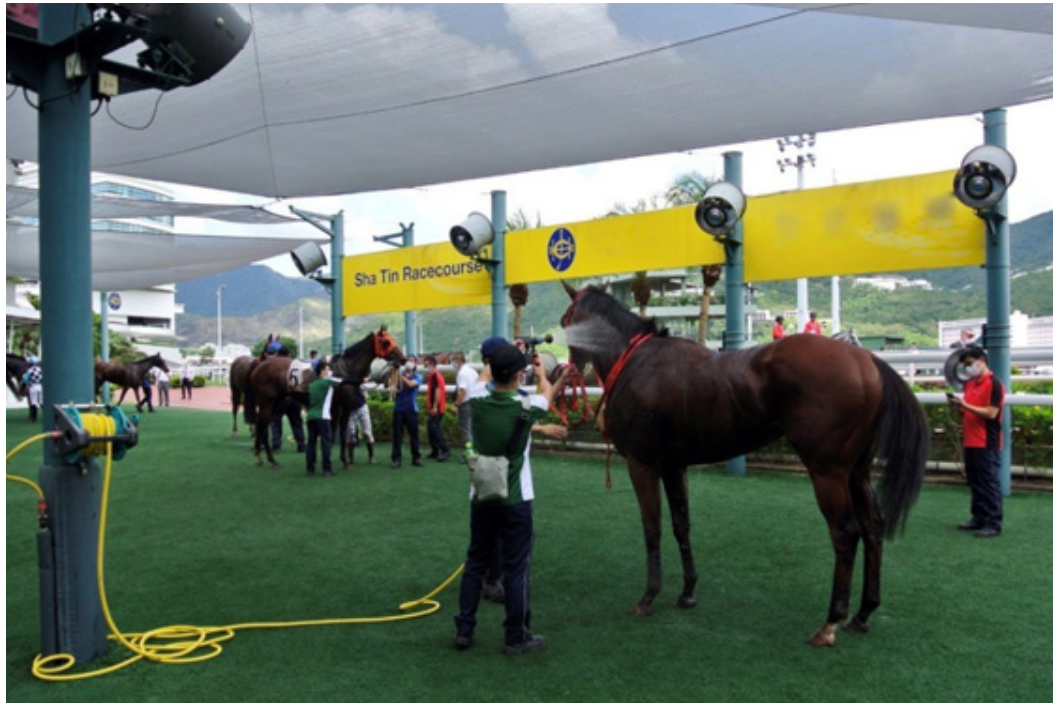
Figure 26. Dismounting enclosure at the Hong Kong Jockey Club, Sha Tin Racecourse. Courtesy of Dr. Peter Curl. The creation of a cooling infrastructure at racetracks such as shown in this photograph is ideal and an important welfare priority. Note the extensive shade cloth, green floor surface, mounted dry fans and multiple long hoses providing cool water.